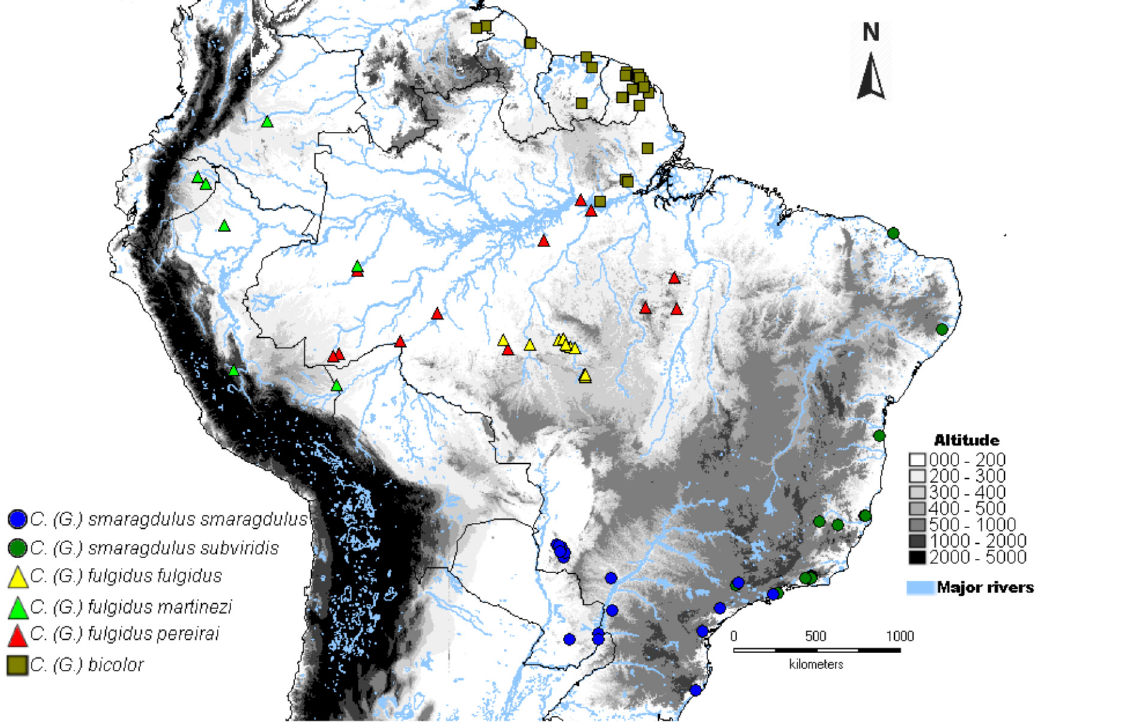
Fig. 8. Distribution map for subspecies of Goniocanthon : C. (G.) fulgidus martinezi subsp. nov. (green triangle); C. (G.) fulgidus pereirai subsp. nov. (red triangle); C. (G.) fulgidus fulgidus Redtenbacher, 1868 (yellow triangle); C. (G.) smaragdulus subviridis Schmidt, 1922 stat. rev. (green circle); C. (G.) smaragdulus smaragdulus (Fabricius, 1781) (blue circle) and C. bicolor Castelnau, 1840 (brown